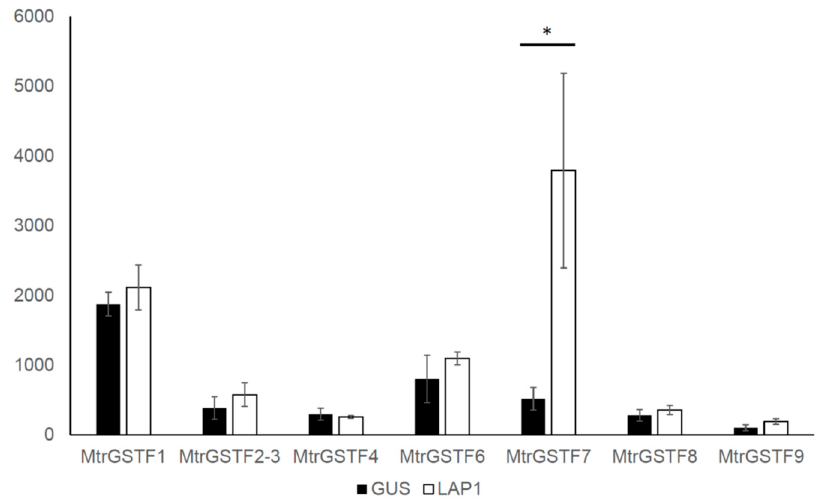
Figure 7. Expression of MtrGSTFs in leaves of 35S::LAP1 (LAP1), showing hyperaccumulation of anthocyanins, and 35S::GUS used as control (GUS). Asterisk indicates log 2 FC > 2. Since glandular trichomes are known sites of PA accumulation, we interrogated the Trichome expression database [27] for phi GST accumulation. Figure 8 reports the expression levels of M. truncatula phi GST s in glandular and non-glandular trichomes. Higher expression was detected for MtrGSTF1 and MtrGSTF6 with log 2 FC value below 2 between the two types of trichomes. All other MtrGSTFs showed lower expression values. This was expected for MtrGSTFs with organ-specific expression in root and seeds. Interestingly, MtrGSTF7 , which is highly expressed in leaves, showed low expression in trichomes.